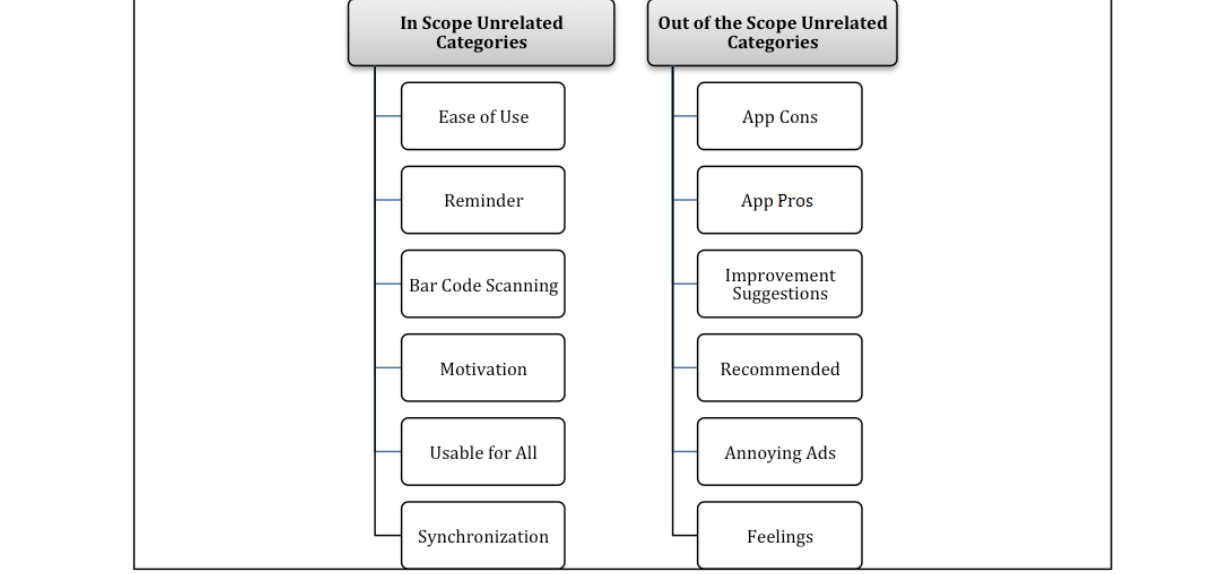
Figure 3. Unrelated categories that resulted from thematic